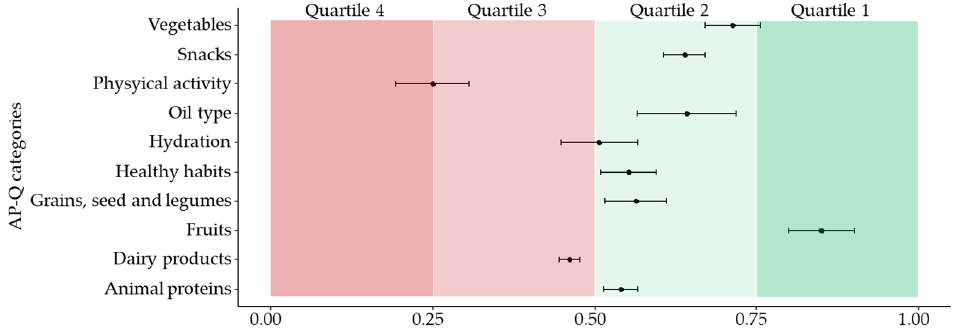
Figure 1. Scores of the AP-Q categories, segmented by quartiles. Data show the median ± standard error of the mean. AP-Q categories range from 0 to 1, being 1 high adherence HFP guidelines.